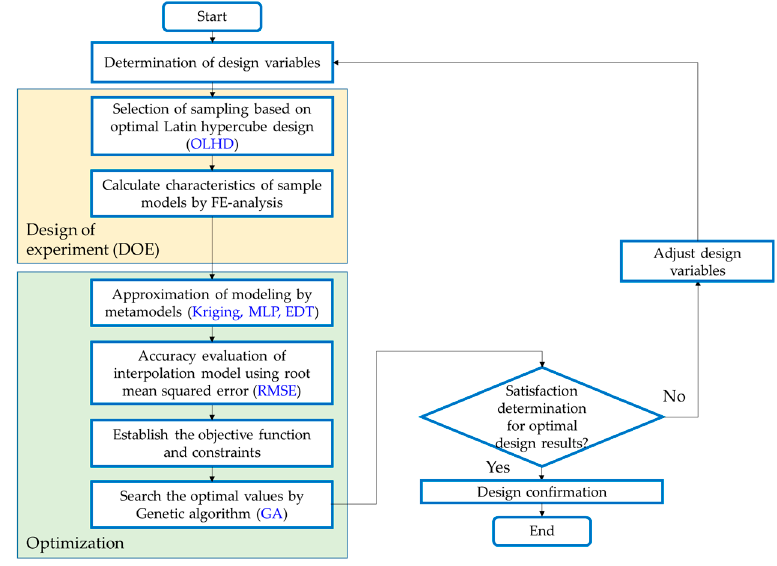
Figure 3. Proposed optimization process.